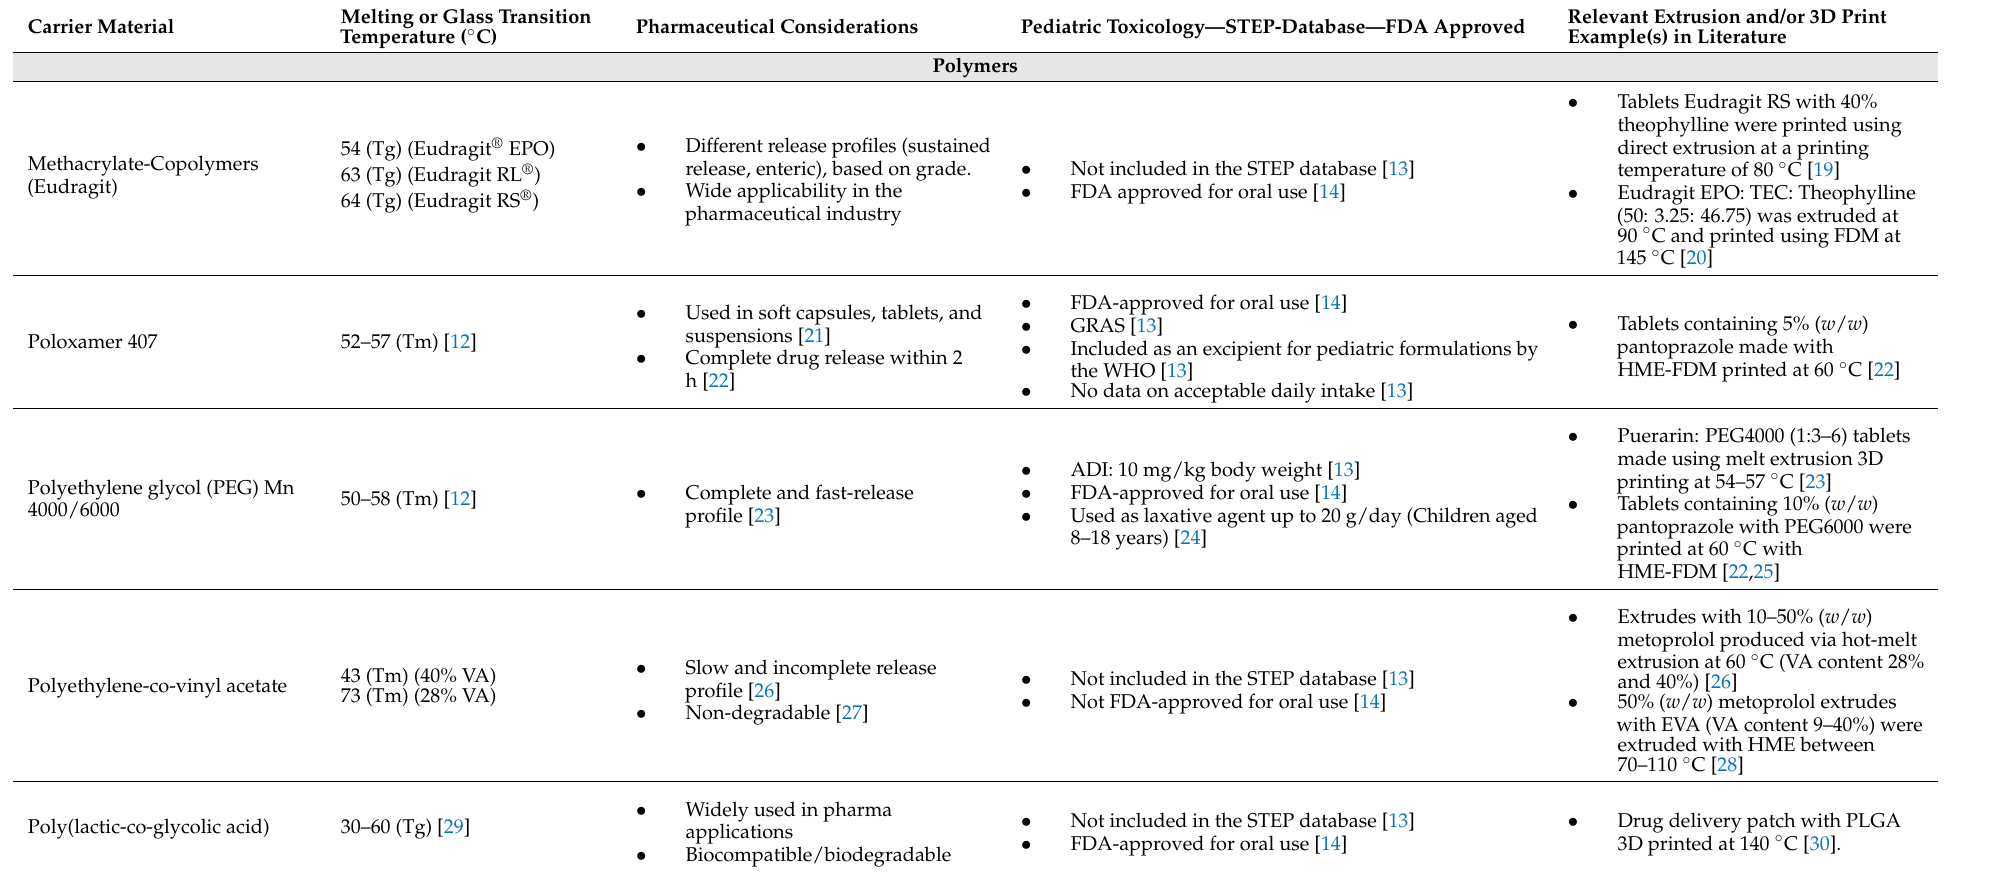
Table 1. Carrier material selection from the